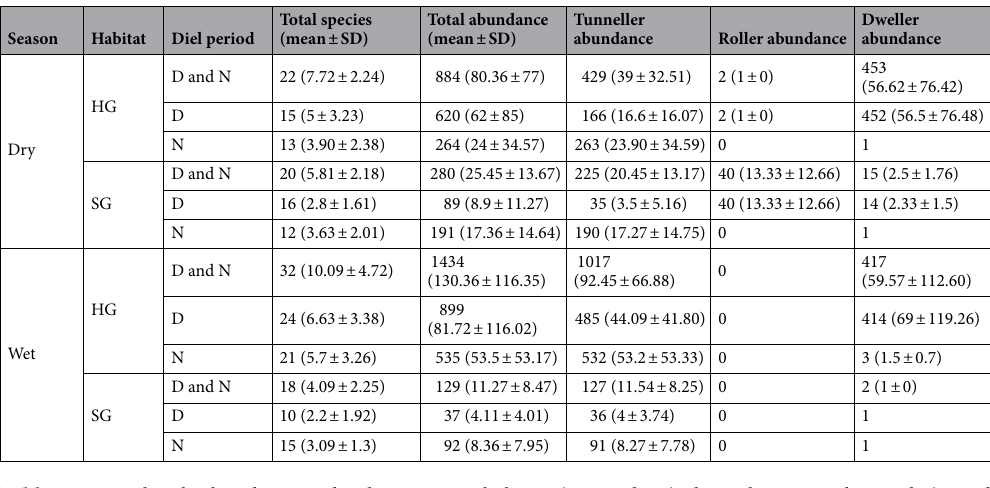
Table 1. Dung beetle abundance and richness across habitats (HG and SG), diurnal-nocturnal periods (D and N), and seasons (Dry and Wet). HG home garden, SG sacred grove, D day, N